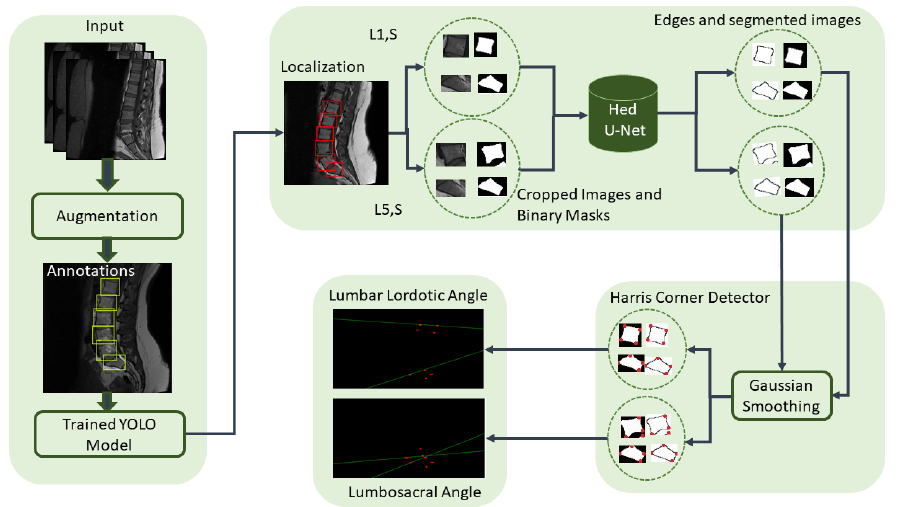
Figure 4. Proposed Framework: Dataset is augmented, annotated, and passed through the YOLOv5 to obtain localized vertebrae. L1 and S for LLA and L5 and S for LSA are extracted from the localized vertebrae, which are then passed through the HED U-Net to obtain the edge-based segmentation. Images are smoothed using Gaussian smoothing filter, and Harris corner detector is applied to obtain the corners of desired vertebrae. LLA and LSA can be found from the